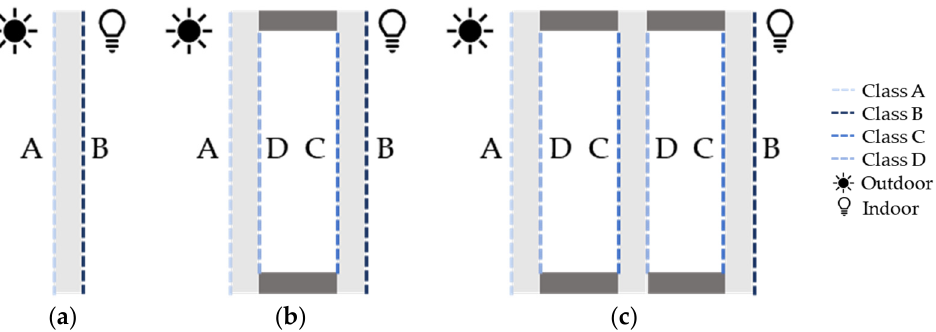
Figure 3. Classes (installation position) of window films: ( a ) Single glazing; ( b ) Double glazing; ( c ) Triple glazing.